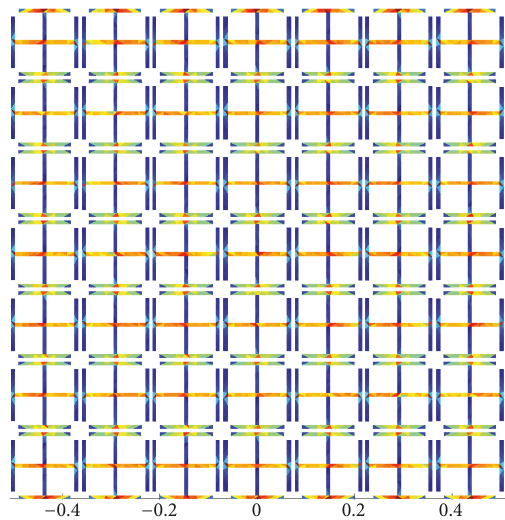
Figure 12: Current distribution in centre of the flat lens with 33 × 33